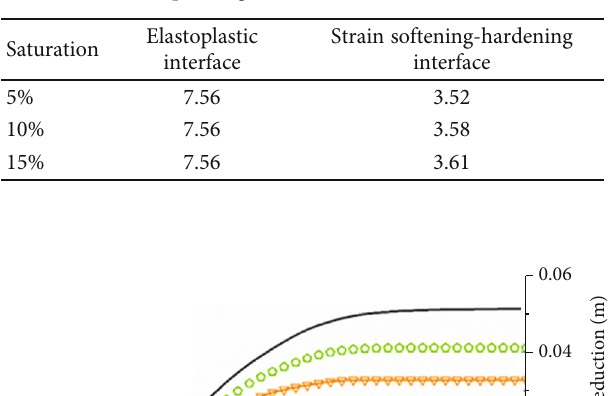
Figure 11: Relationships between radial, circumferential, and vertical stresses and r / a at di ff erent hydrate Table 4: Elastic-plastic interface and strain softening-hardening interface r / a corresponding to di ff erent saturations.